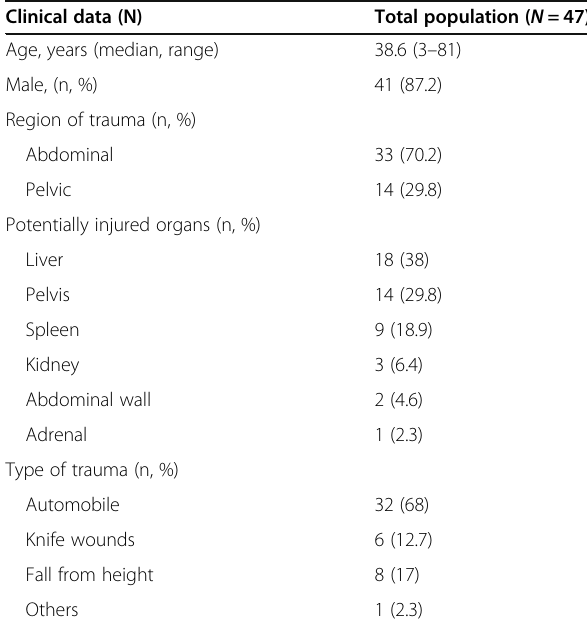
Table 1 Clinical data of patients Clinical data (N) Total population ( N =